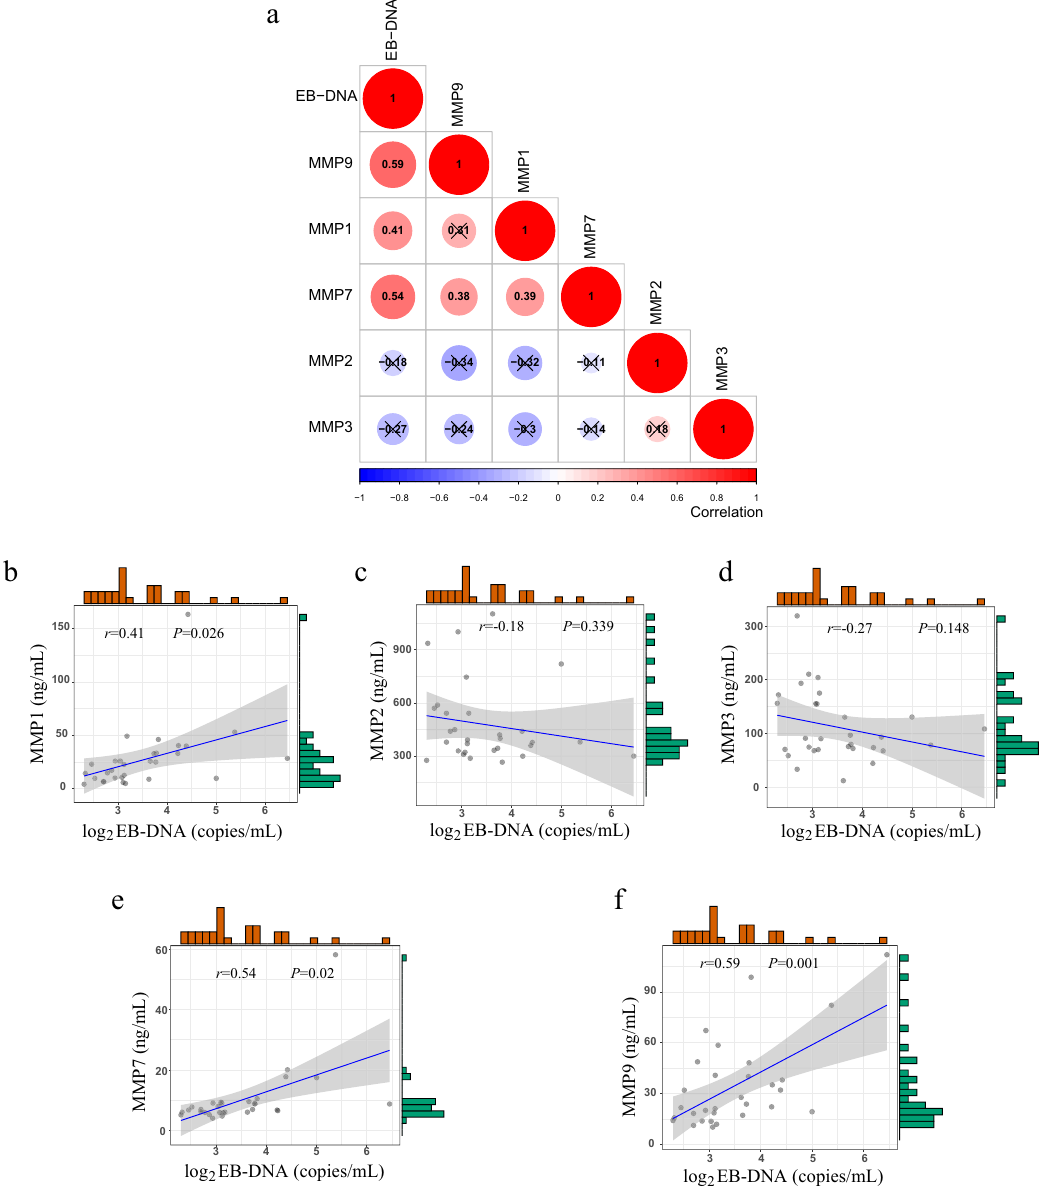
Fig. 9 Clinical relevance of MMPs and EBV-DNA levels for NPC patients. a Heatmap visualizing the correlation of EBV-DNA level with each MMP. Scatter plots presenting the correlation of EBV-DNA level with b MMP-1, c MMP-2, d MMP-3, e MMP-7, and f MMP-9. The histograms represent the frequency distribution of MMP and EBV level. The correction coef fi cient ( r ) was obtained by performing the Pearson ’ s correction analysis, and no adjustments were made multiple Preparation of W(CO) 5 on gold nanoparticles . Ten milliliters of ethanolic solu- tion containing 2.6×10 11 particles of 60nm gold colloids (BBInternational UK) were mixed with 1mMW(CO) 6 . The solution in a 4-cm quartz cell was irradiated with a photolysis light source (Philips HPK 125-W medium-pressure mercury arc). After irradiation for 12h, the solution was centrifuged at 177×g for 1min. The formed pellet was collected and washed with 1mL of ethanol three times. Preparation of Re(CO) 5 and Mn(CO) 5 on gold nanoparticles . Re(CO) 5 Cl (Sigma Aldrich) or Mn(CO) 5 Cl was obtained from Sigma Aldrich. Freshly prepared ethanolic After 24h of incubation at 28°C, the nanoparticles was collected by centrifugation at 177×g for 1min, and washed with 1mL ethanol for three times. Preparation of CpM(CO) 2 -Au nanotags (M = Os and Ru) . In a typical reaction, 60nm gold nanoparticles (3 mL, 2.6× 10 10 particles/mL) were centrifuged and